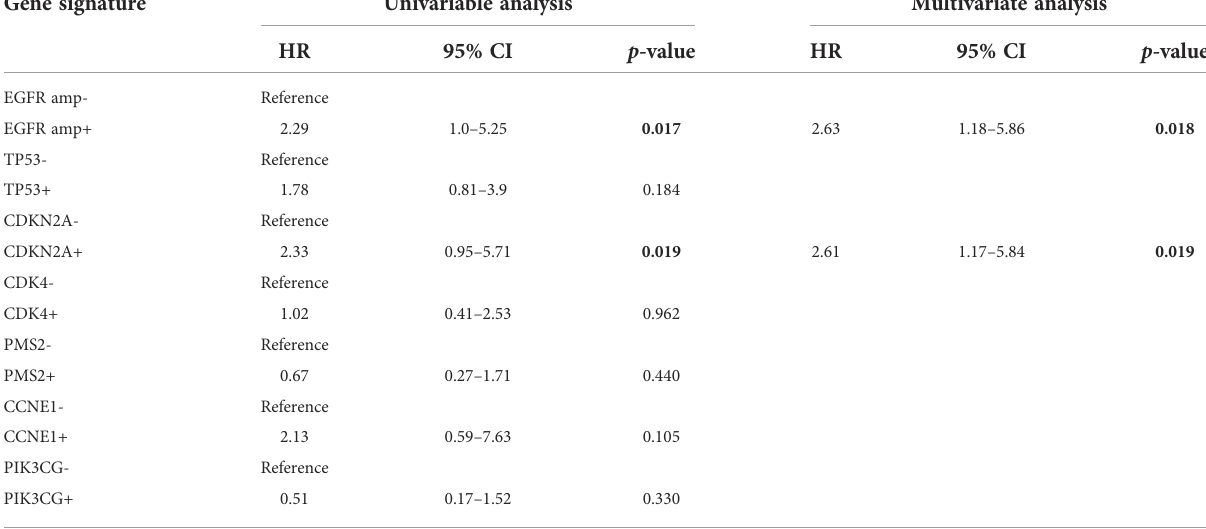
TABLE 3 Univariable and multivariable analyses of gene signature detected in not less than 10% of the study cohort, and the results shown were obtained by performing the Cox regression model ( N =